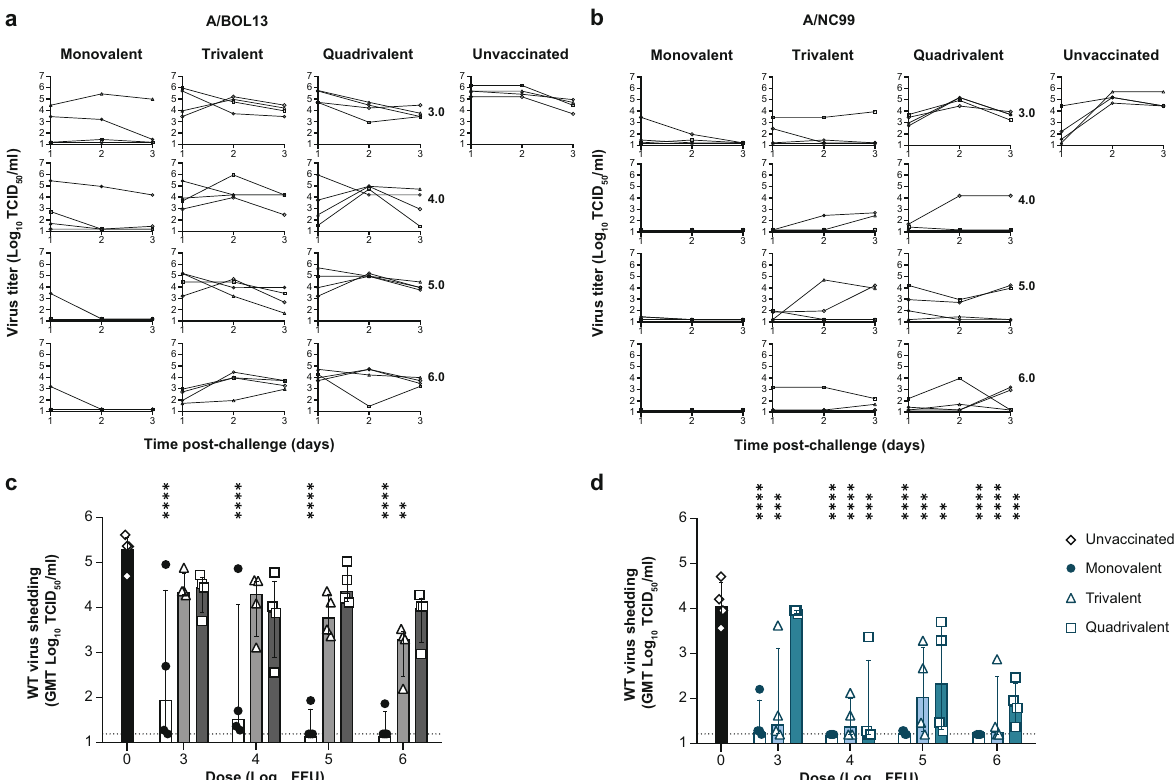
Fig. 5 A/BOL13 provides reduced protection against wt challenge virus shedding. Shedding of homologous wt challenge virus was measured by TCID 50 assay daily, Days 1 – 3 post-challenge. Shedding kinetics for individual animals are shown in a (A/BOL13) and c (A/NC99). Each curve represents shedding data from an individual animal (four animals per dose group). Wt virus shedding was expressed as the geometric mean of virus titer over Days 1 – 3 post-challenge. Protection from wt virus shedding for monovlaent, trivalent, and quadrivalent LAIV groups is summarized in b (A/BOL13) and d (A/NC99). Data shown are geometric mean virus titers for individual animals (symbols), with four animals per dose group. Columns and error bars for all virus titer data show group median and interquartile range. Statistical comparison between groups was performed by two-way analysis of variance with Sidak ’ s post-test correcting for multiple comparisons. Assessment of protection from wt shedding compared vaccinated groups to unvaccinated controls. * P < 0.05, ** P < 0.01, *** P < 0.001, **** P < 0.0001. Dotted lines indicate lower limit of detection; values below this were plotted as 0.5× the lower limit of detection. A/BOL13 A/Bolivia/559/2013, A/ NC99 A/New Caledonia/20/1999, FFU fl uorescent focus units, GMT geometric mean titer, LAIV live attenuated in fl uenza vaccine, NT